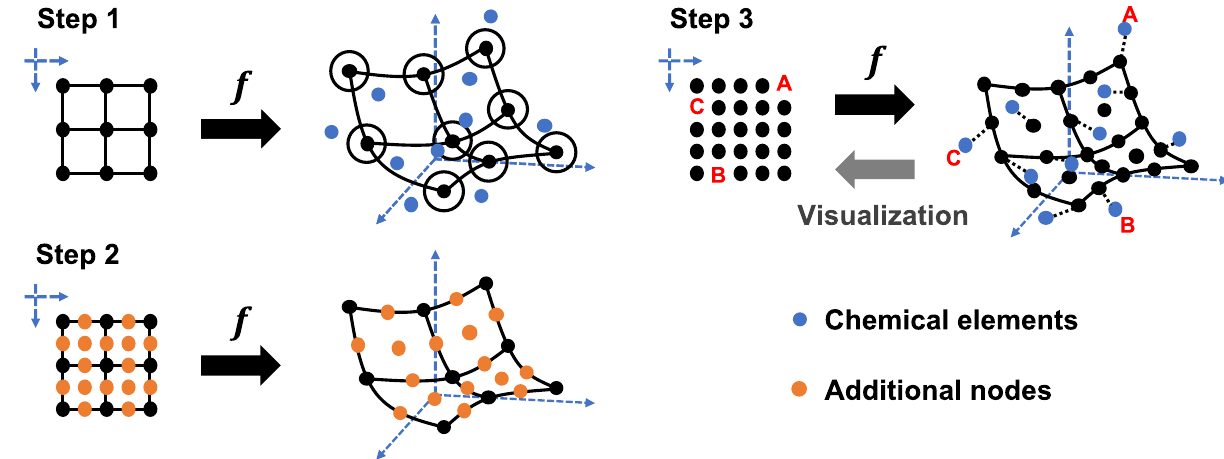
Figure 1. Workflow of PTG that relies on a three-step coarse-to-fine strategy to reduce the occurrence of undesirable matching between chemical elements and redundant